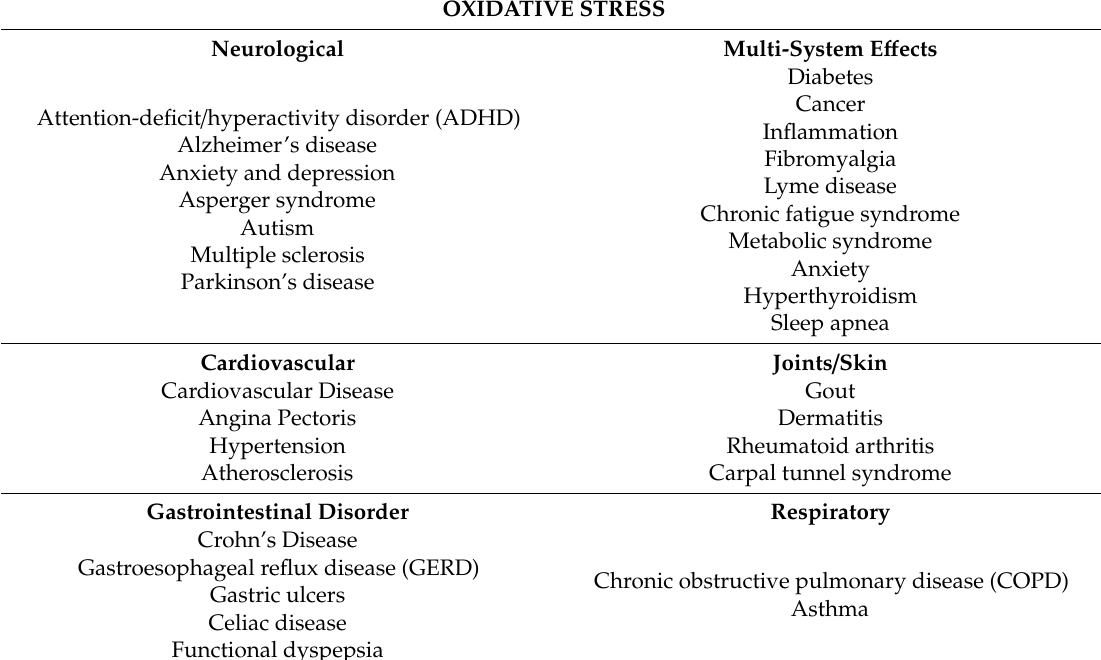
Table 1. Summarization of diseases and side e ff ects of oxidative stress. OXIDATIVE